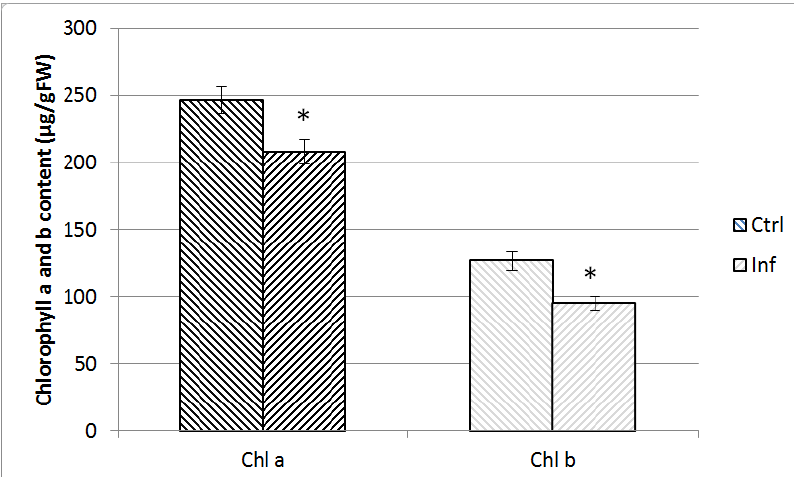
Figure 2. Contents of chlorophyll a (Chl a) and chlorophyll b (Chl b) in the control (Ctrl) and infected (Inf) tomato leaves. The asterisks on the column indicate a highly significant difference between the two treatments (Ctrl and Inf) at the nematode infestation time ( t -test; * p < 0.05).